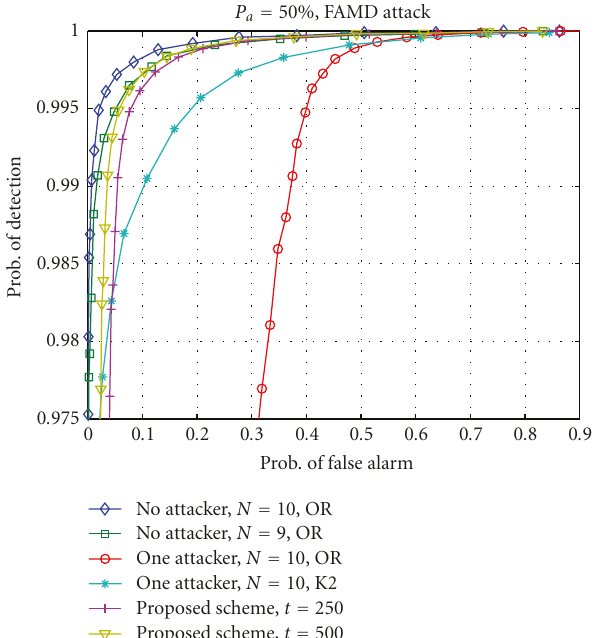
Figure 7: ROC curves (False Alarm Attack, Three Attackers).